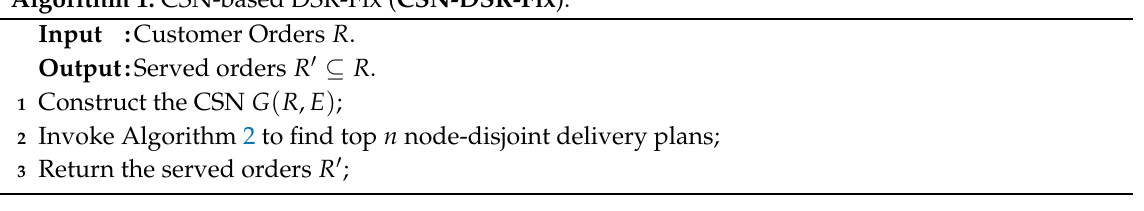
Figure 2. An illustration on how CSN works. ( a ) The directed edge ( r j , r k ) indicates that the order r k can be finished immediately after r j ; ( b ) the Hopcroft–Karp maximum-matching (red arrows); ( c ) the optimal delivery plans r 1 → r 4 and r 2 → r 3 → r 5 . Algorithm 1: CSN-based DSR-Fix ( CSN-DSR-Fix ).